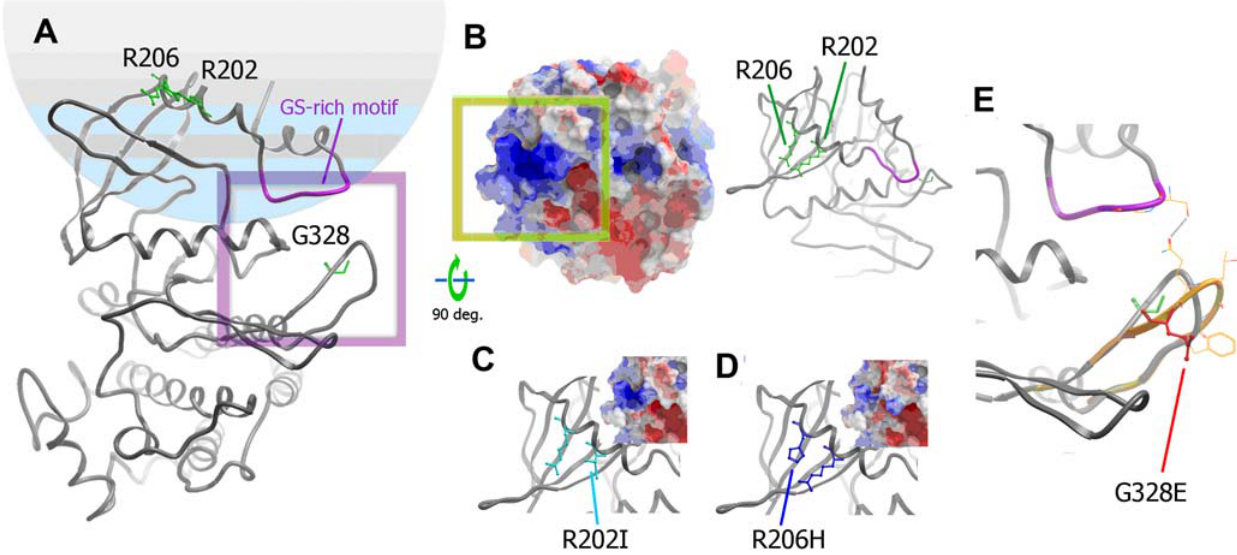
Figure 3. Homology models of ACVR1. ( A ) Wild-type ACVR1 kinase domain. The residues where mutations are described in this study are represented as sticks (green, labelled). A ribbons representation of the GS-rich motif is highlighted in magenta. A purple frame marks the zoomed area in panel E. ( B ) wild-type ACVR1 model rotated 90 u around the X-axis to show the surface occluded upon binding of FKBP12 (shown both as ribbons and surface coloured according to electrostatic potential). The green box denotes the positive patch seen in the model of wild-type ACVR1. ( C ) and ( D ) mutations Arg202Ile and Arg206His are shown as ribbons, with the mutations indicated (same view as panel B). The predicted electrostatic potential for each mutant protein is shown in the insert (framing is equivalent to the green box of panel B). ( E ) Mutation Gly328Glu induces a significant conformational change in the loop where it is sited. One of the putative conformations is depicted in orange (wild-type loop conformation shown in grey). In this example a potential direct interaction could be formed between the modelled loop and the GS-rich